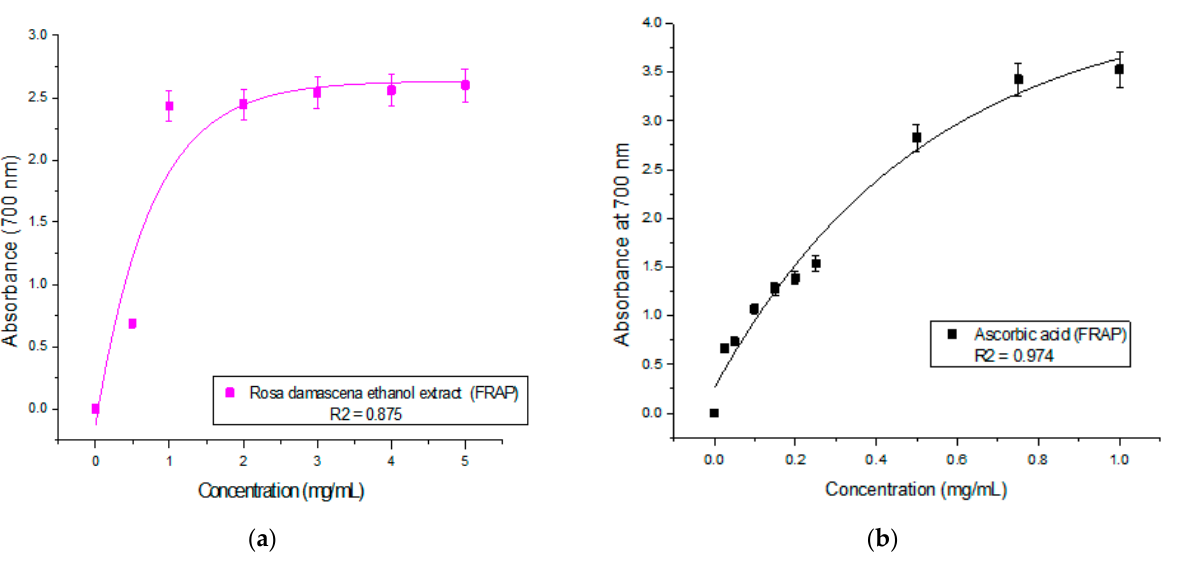
Figure 3. FRAP of the hydroethanolic extract obtained from Rosa damascena flowers ( a ) and ascorbic acid ( b ).